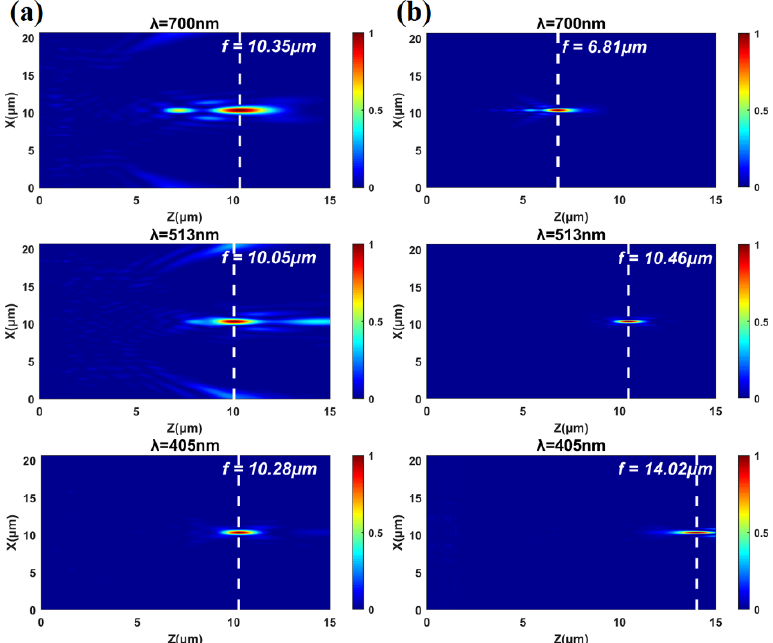
Figure 4. Normalized electric field intensity distributions in the xz plane for ( a ) an achromatic focusing and ( b ) an initial chromatic focusing.